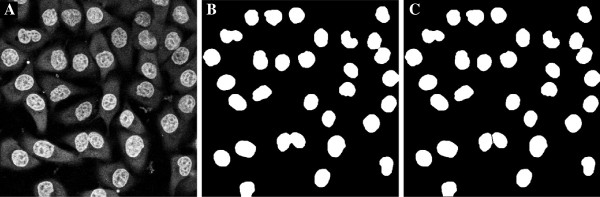
Segmentation of Hoechst stained nuclei in 3D using segmct, from Example 11. A) Raw nucleus stain, B) segmentation with iterative thresholding (prm.method = ’itth’) without splitting of cells, C) after splitting of cells. Note that after splitting several connected nuclei are disconnected into their separate compartments.